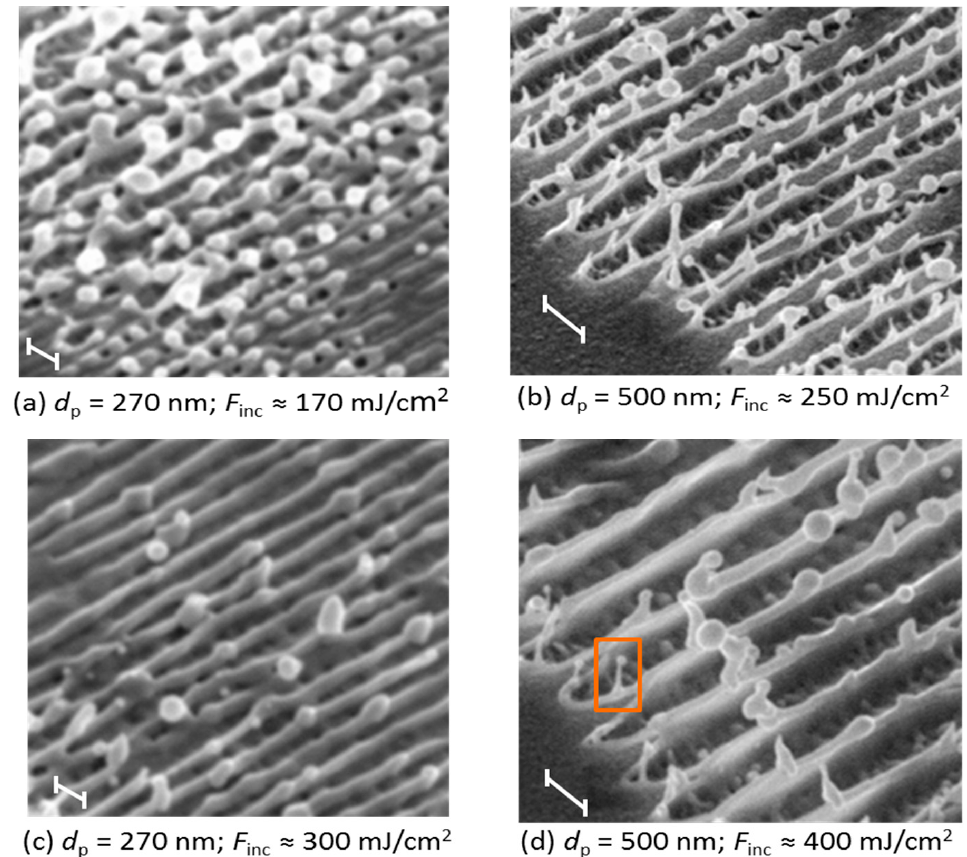
Figure 5. Periodic patterns obtained with periods of 270 nm in ( a ) and ( c ) and 500 nm in ( b ) and ( d ) at various fluences, at a tilt angle 45°, the period is indicated by the scale bars. For larger periods, a higher fluence is required to obtain nanoridges composed of two collided walls. The squared structure in ( d ) is experimentally identified and obtained in simulations (Figure 6).